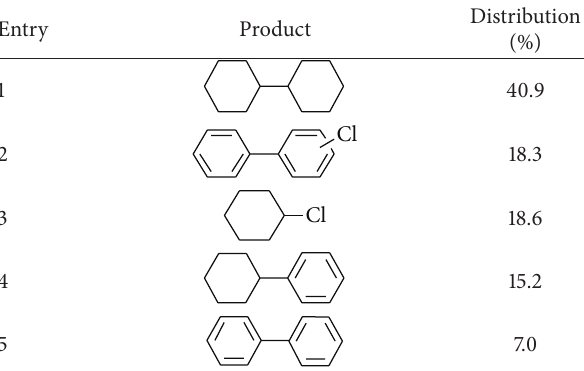
Table 4: The distribution of the products generated from direct cross-coupling of chlorobenzene with cyclohexane under UV light irradiation a (see Scheme 5).